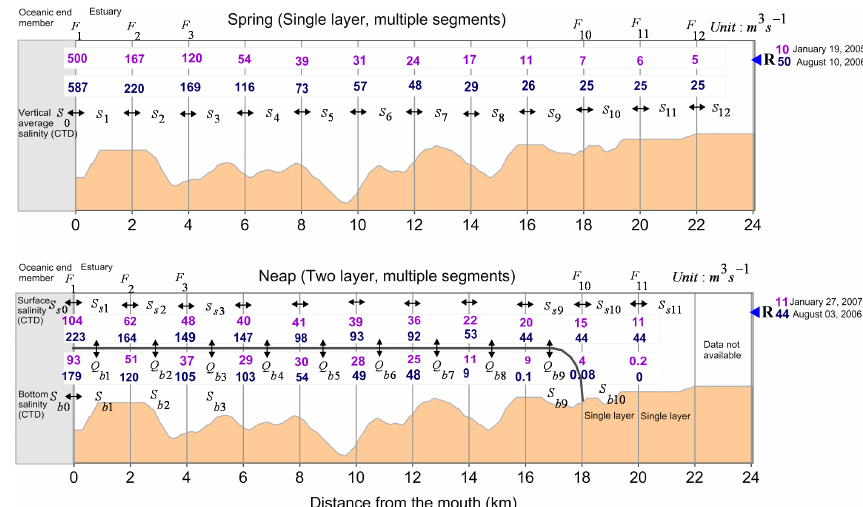
Fig. 6. Schematic diagram illustrating the calculation of flushing rate at the boundary between two adjacent segments for well and partially mixed condition during spring tide (upper) and for stratified condition during neap tide (lower) with low (10 and 11m 3 s − 1 ) and high (50 and 44m 3 s − 1 ) river discharges ( R ). In two layer system during neap tide, the outflow ( F i ) from the surface layer to the ocean through boundary is the sum of deep flow volume ( Q bi ) plus river discharge.